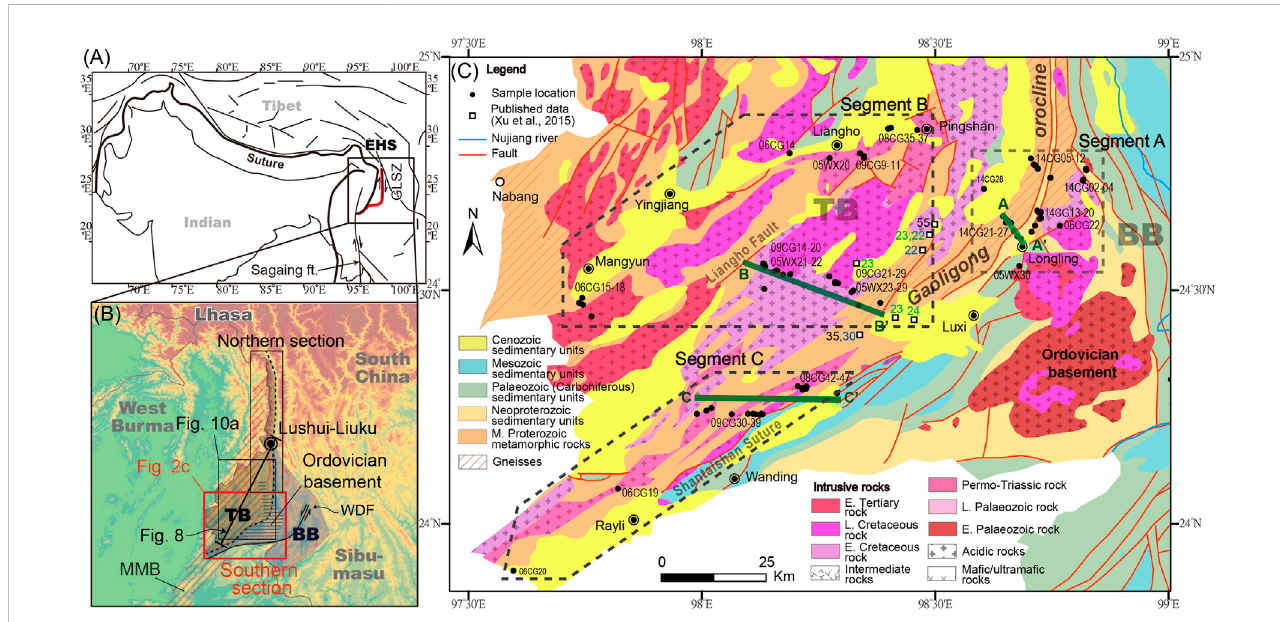
FIGURE 2 Tectonic and geological maps of the study region. (A) Sketch diagram showing the general tectonic framework of the oroclines. Most oroclines are convex toward the Indian plate; only the section from EHS to Sagaing fault and the Gaoligong shear zone are convex toward the mantle wedge. The map is modi fi edfromBajoletetal.(2013). (B) TopographymapwithadigitalelevationmodelshowingthedistributionoftheTengchongblock(TB,translucentbrown block)andBaoshanblock(BB,translucentblueblock).ThebrownhashlinemarkstheMogokmetamorphicblock(MMB),andtheOrdovicianbasementis marked by the gray horizontal line (Ye et al., 2020). WDF — Wanding fault. (C) Geological map of the Gaoligong orocline showing lithology units, fault distributions,cross-sections,andsamplelocation.ThepublishedagesarequotedfromXuetal.(2015).TheblacknumbermarkstheageofzirconU-Pbdating, the blue marks the age of hornblende Ar – Ar dating, and the green marks the age of biotite Ar – Ar dating. The map is modi fi ed from BGMRYP (1983), Ma et al. (2014), and Xu et al.